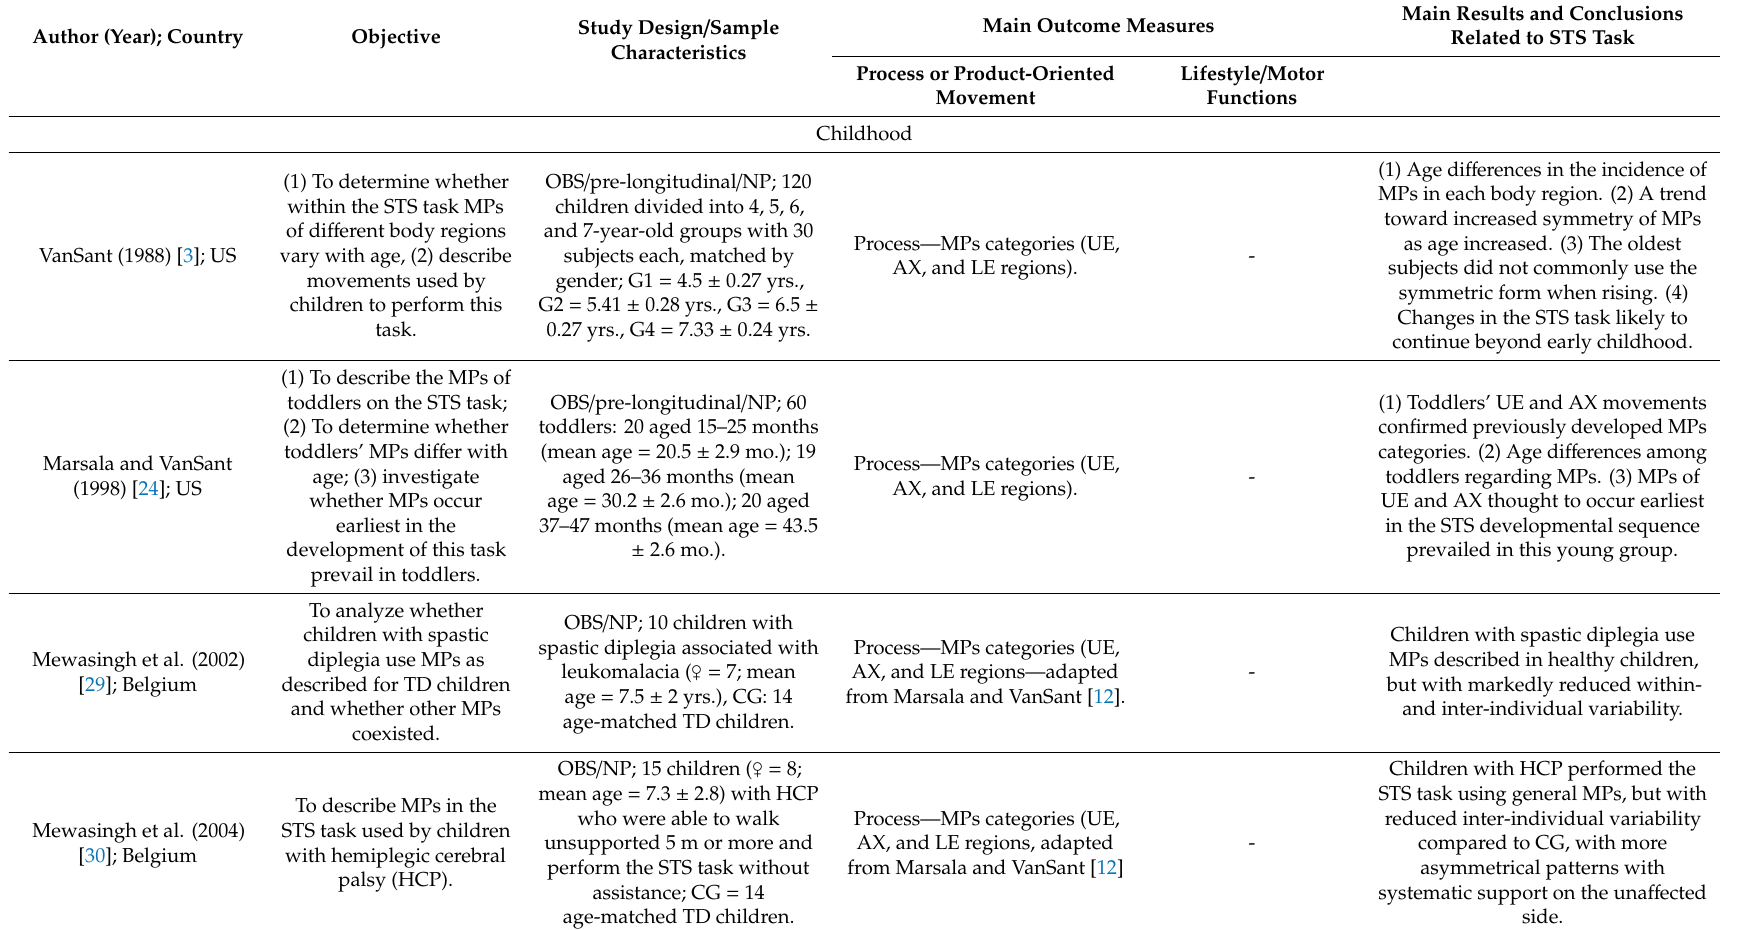
Table 1. Methodological characteristics, main results, and conclusions from studies on STS task (ordered by developmental phase and year of publication). The table was originally created by the